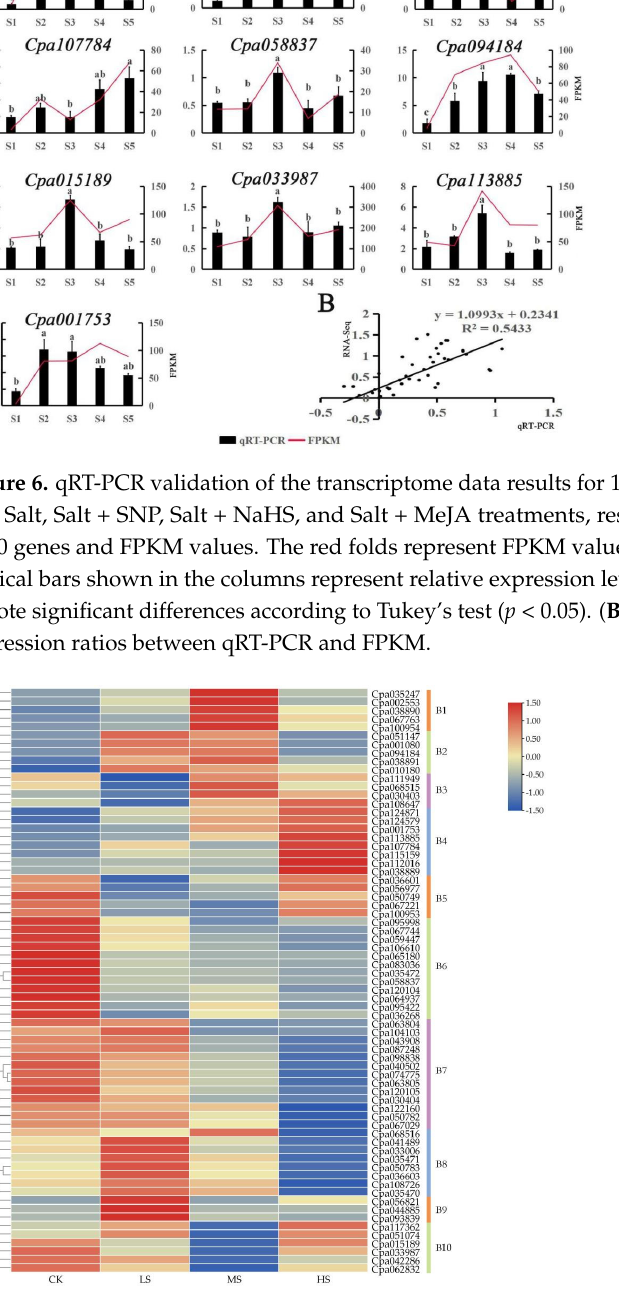
Figure 7. Clustering expression analysis of 69 CpaMYB genes in salt stress based on hydroponic experiments. The CK, LS, MS, and HS represent NaCl concentrations of 0%, 0.15%, 0.3%, and 0.45%, respectively. The transcript abundance level was normalized and hierarchically clustered by using the log 2 (FPKM + 1) comparison among genes of different treatments. The expression value is pre- sented on the color scale, with red representing high expression and blue representing low expres- sion. B1–B10 represent different clusters. In order to distinguish B1–B10 clusters more intuitively, lines of different colors were used on the right.